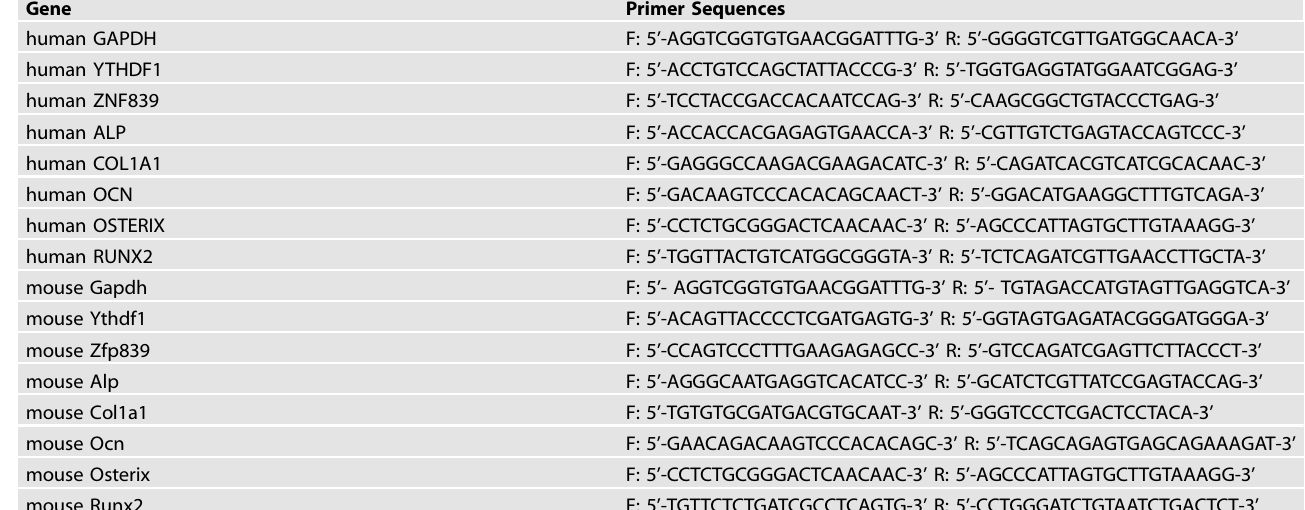
Table 2. Primer sequences for